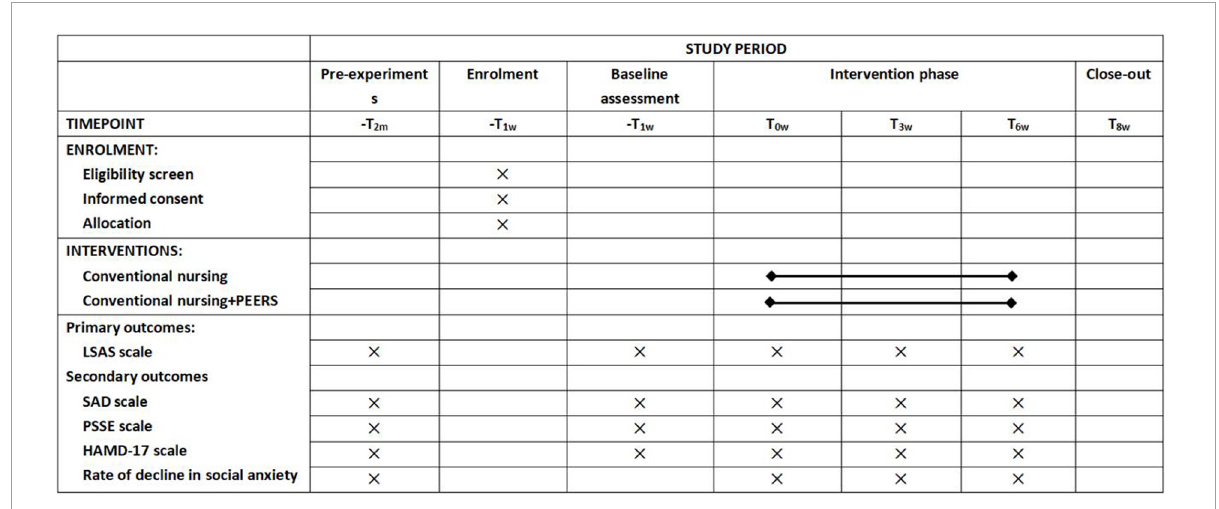
FIGURE1 Schedule of enrollment, intervention, and assessment (m = month, w =